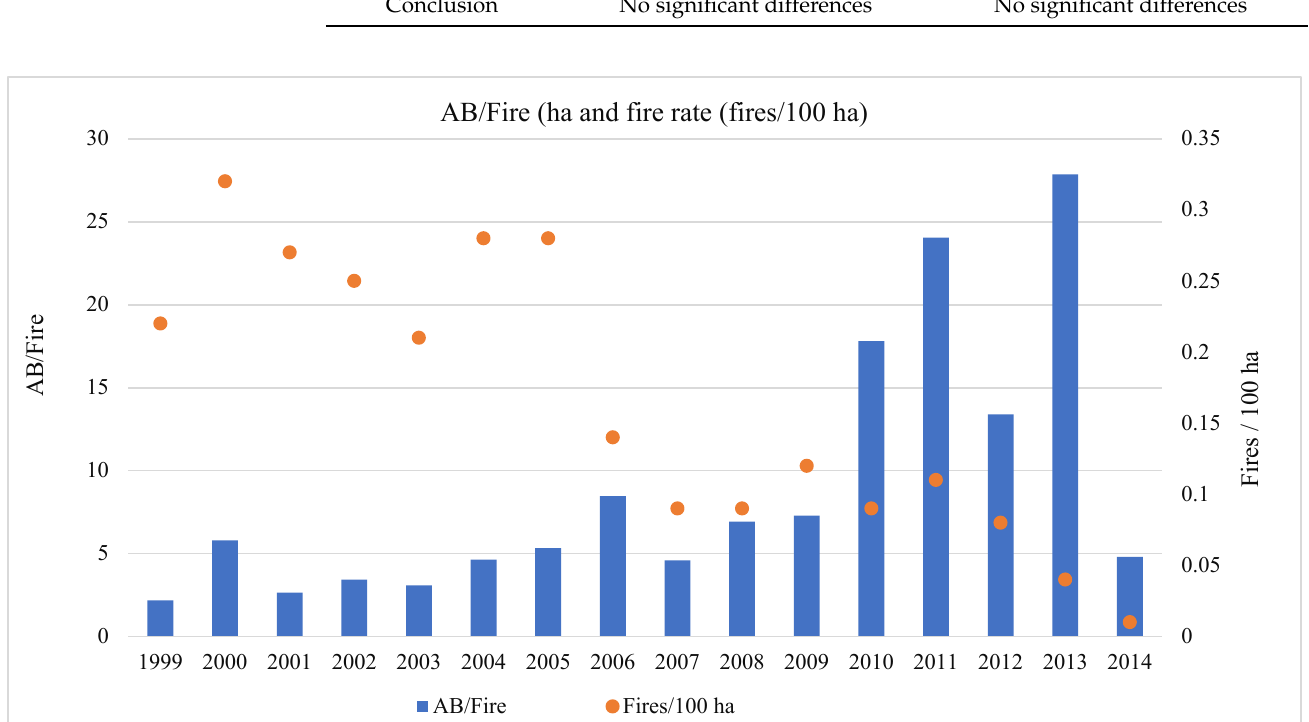
Figure 13. The area burnt per fire (AB/fire) and the rate of fires per 100 ha in the SACs (orange dots) during the study period. The decrease in the fire rate is similar to that observed in Galicia. A notable increase in the area burnt per fire is observable. Table 4. Significant differences in the rate of forest fires and in the area burned by fire (BA/wild- fire) in SACs, before and after 2004.